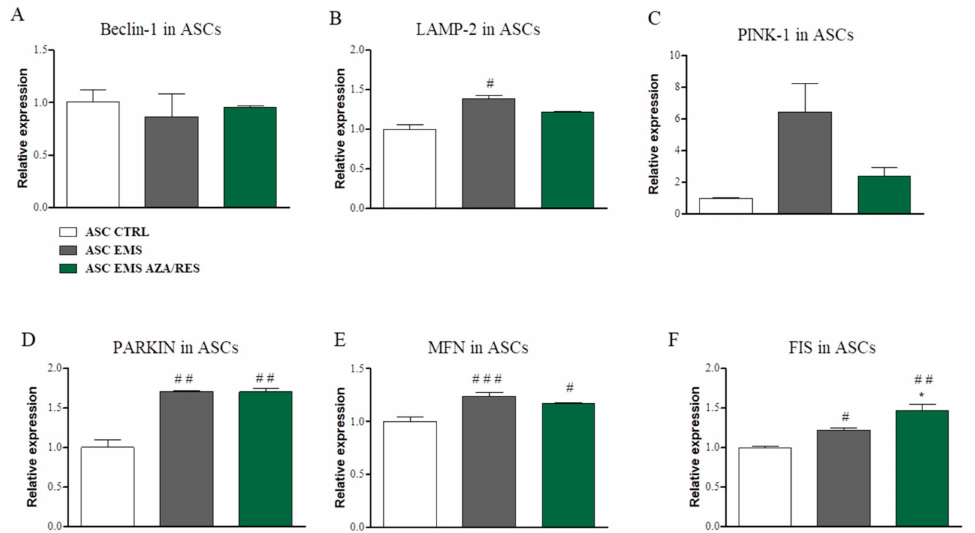
Figure 8. Auto- and mitophagy in ASCs co-cultured with RAW264.7 macrophages. After co-culture, ASC were collected and subjected for RT-PCR. Expression of Beclin-1 ( A ), LAMP-2 ( B ), PINK-1 ( C ), PARKIN ( D ), MFN ( E ), and FIS ( F ) was evaluated. Statistical significance was labelled with hash (#) when comparing to control group (ASC CTRL ) and asterisk (*) when comparing to EMS group (ASC EMS ). Results expressed as mean ± S.D. #, * p < 0.05; ## p < 0.01; ### p <